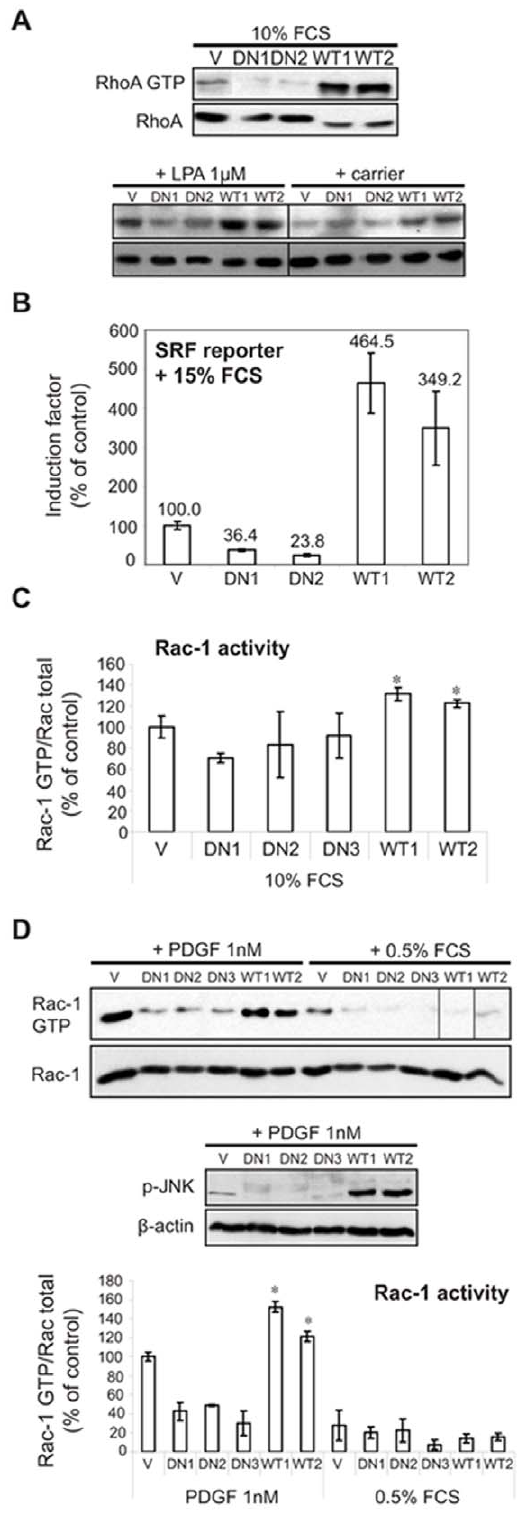
Figure 4. PI3KC2 b regulates RhoA and Rac1 activity. (A) PI3KC2 b up-regulates RhoA activity. NIH3T3-V, -C2 b -DN and –C2 b –WT cells were grown in 10% FCS or serum-starved for 24 h and stimulated with 1 m M LPA for 2 min. Cell lysates were equalized for protein content and subjected to GST-rhotekin pull-down as measure of RhoA activity. GTP- bound and total RhoA were detected with an anti-RhoA antibody.